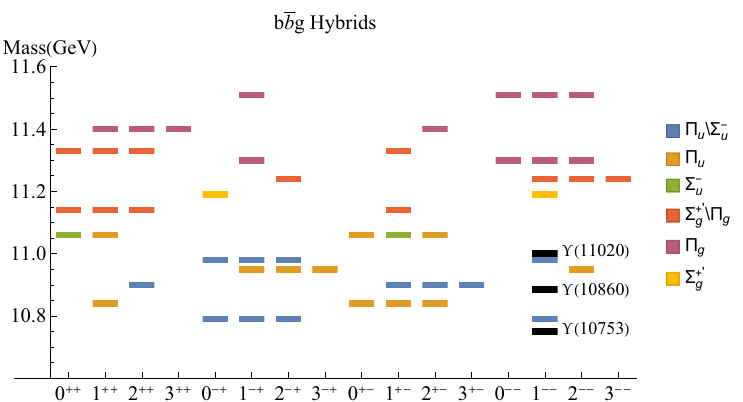
Figure 2. Bottomonium hybrid spectrum from Refs. [4, 18]. Each line represent a state. The color of each line indicates the static energies that contribute to each state. The black lines correspond to the three neutral exotic bottomonium states discovered so